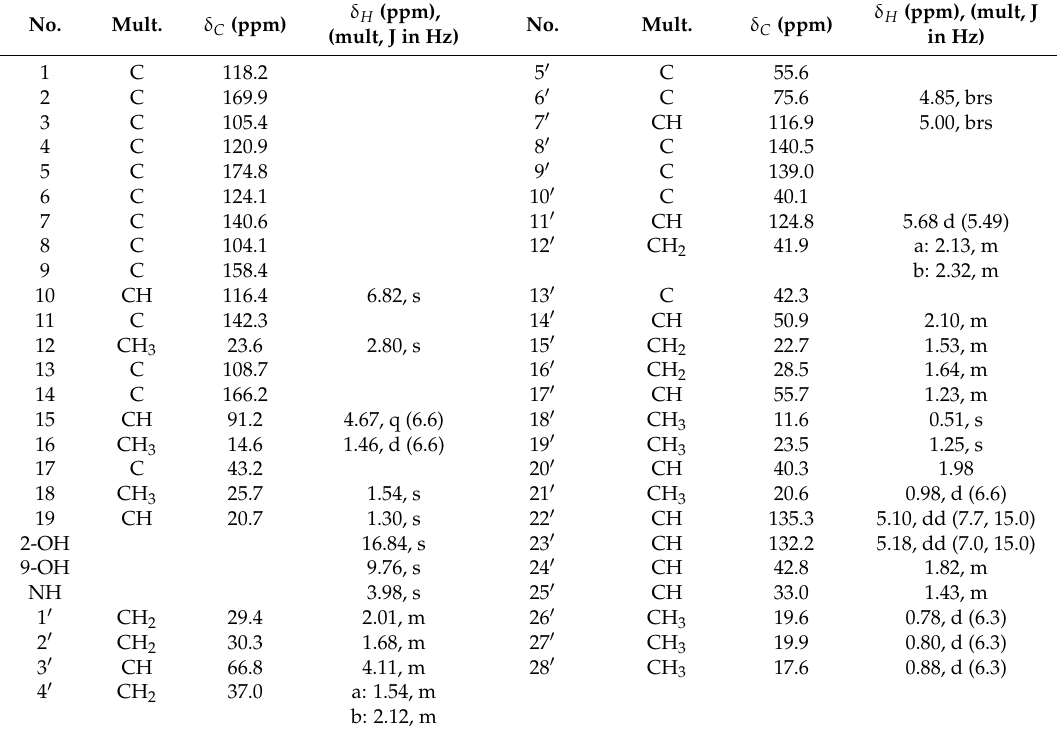
Table 2. NMR (CDCl 3 ) spectroscopic data for S -dehydroazasirosterol ( 2